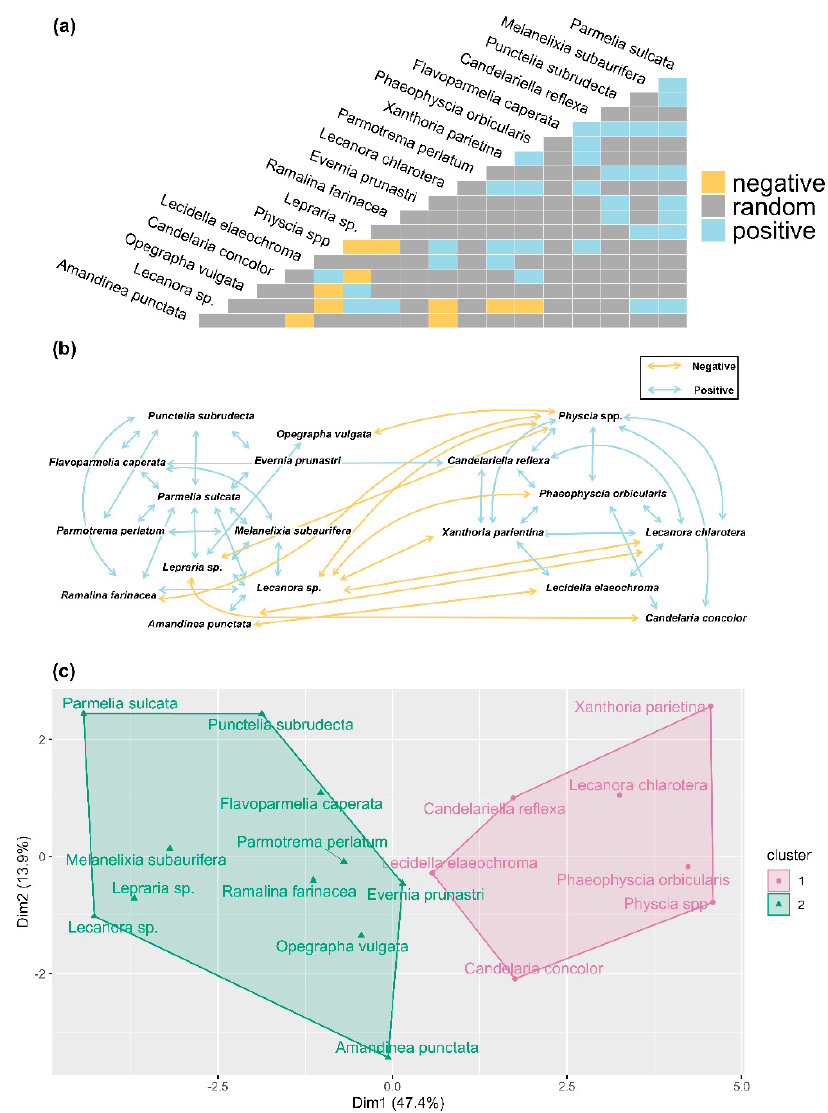
Figure 4. Epiphytic lichen communities from paired species co-occurrence probabilities calculated via the Veech et al. (2013) method. ( a ) Species co-occurrence matrix showing significant positive (blue), negative (yellow) and random (grey) co-occurrences ( p < 0.025); ( b ) visual representation of matrix in (a) showing the emergence of two separate lichen communities, with positive co-occurrences within communities and negative between and ( c ) result of partitioned around medoids clustering analysis using cooccur e ff ect sizes of paired-species co-occurrences and grouping species pairs in to k = 2